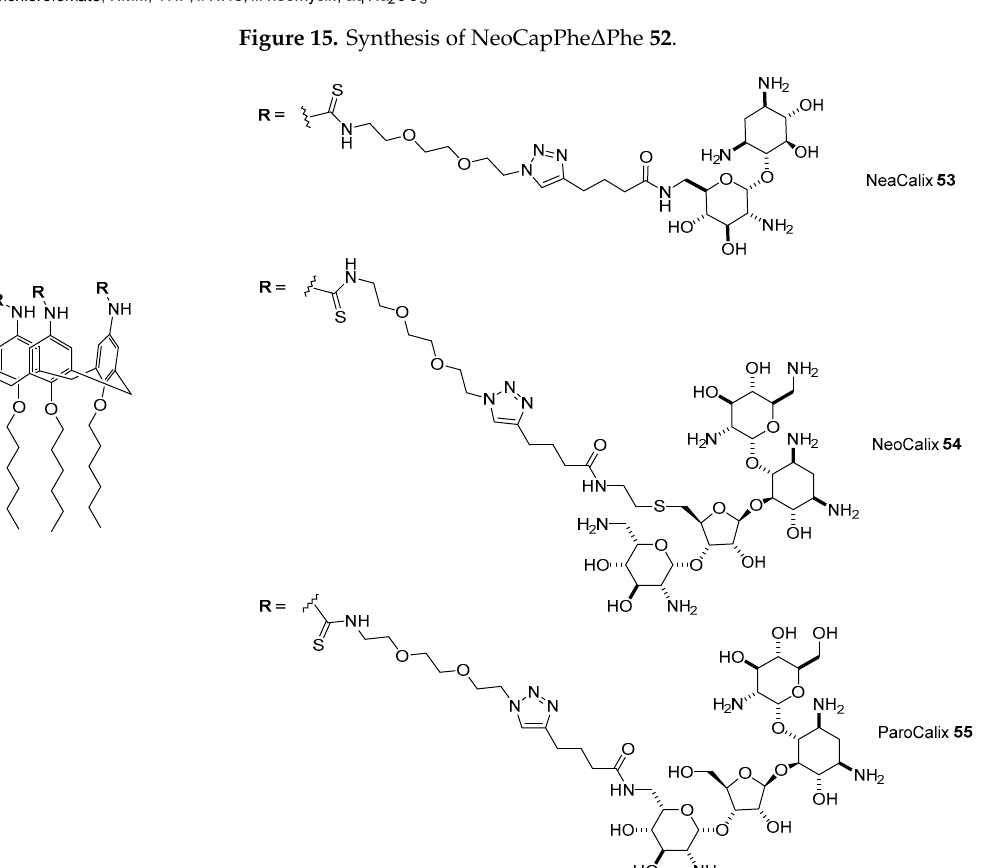
Figure 15. Synthesis of NeoCapPhe ∆ Phe 52 .